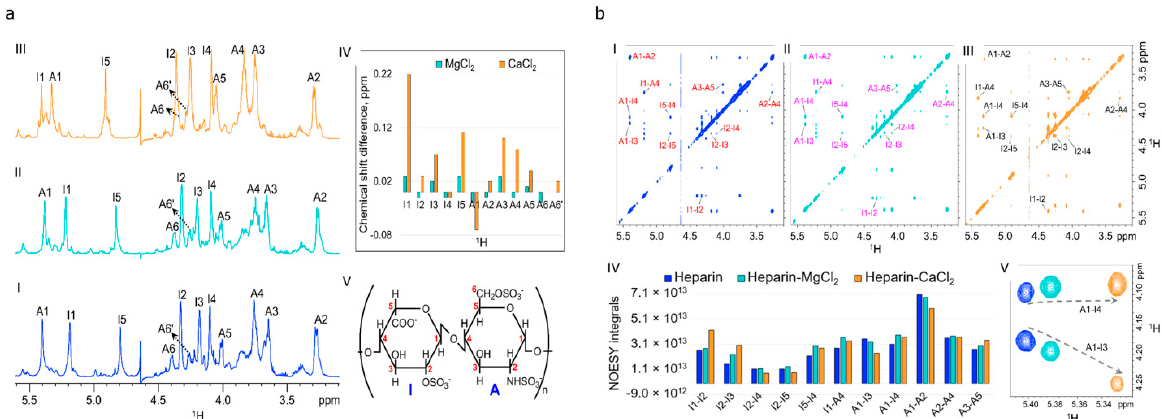
Figure 2. NMR analyses of magnesium chloride modified heparin: ( a ) Comparison of a portion of 1D 1 H NMR spectra of heparin (I), heparin–Mg 2+ (II), and heparin–Ca 2+ (III) acquired in 99.95% D 2 O at 37 °C. Proton chemical shift assignment of iduronic acid, and glucosamine, residues are shown on top of each resonance. (IV) Bar plot showing 1 H chemical shift perturbation of heparin in the presence of Mg 2+ and Ca 2+ . 1 H chemical shift difference between heparin–M 2+ (M = Mg, Ca) and heparin are presented on the y-axis. Positive value indicates the deshielding of respective protons in the presence of M 2+ (M = Mg, Ca). (V) Structure of the repeating disaccharide (iduronic acid-glucosamine) unit of heparin; ( b ) A portion of 2D NOESY spectra of heparin (I), heparin–Mg 2+ (II), and heparin–Ca 2+ (III) in 99.95% D 2 O at 37 °C. Assignments are shown for the characteristic NOE cross-peaks. (IV) Bar plot representation of intra- and inter-residue NOE cross peak volumes. (V) Change in NOESY cross peak intensities of inter-residue A1-I4 and A1-I3 protons of heparin (blue), heparin–Mg 2+ (cyan), and heparin–Ca 2+ (orange).